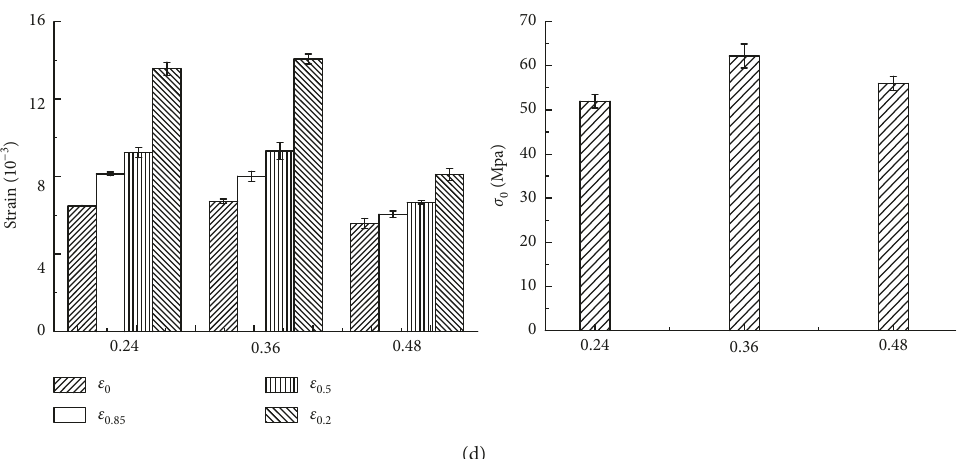
Figure 5: Influence of factors on the characteristic points of stress-strain curves of HDC. (a) Fiber content. (b) Water-binder ratio. (c) Fly ash content. (d) Sand-binder ratio.